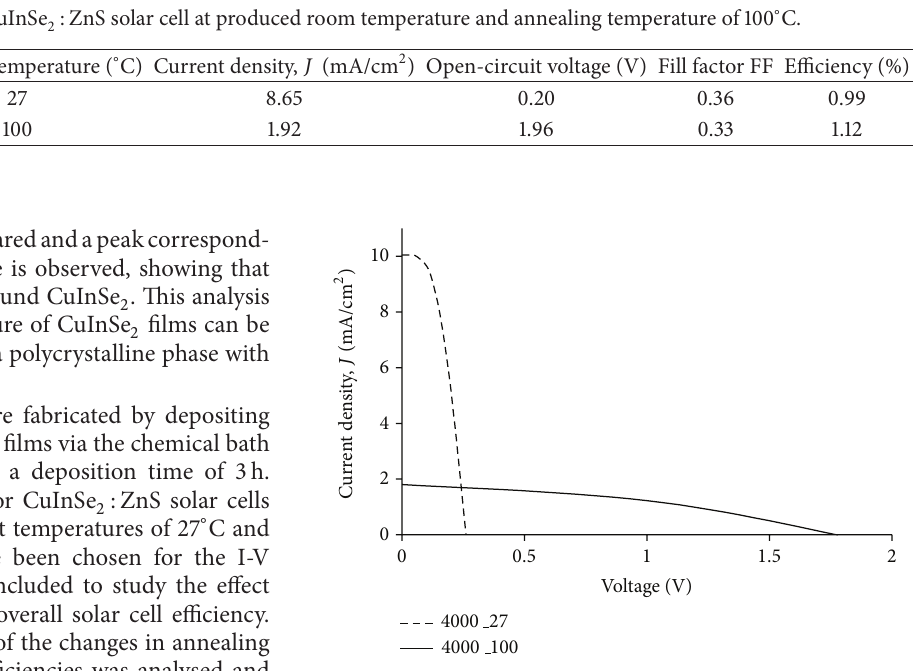
Figure 5: I-V measurement CIS: ZnS solar cell with room temper- ature (27 ∘ C) and 100 ∘